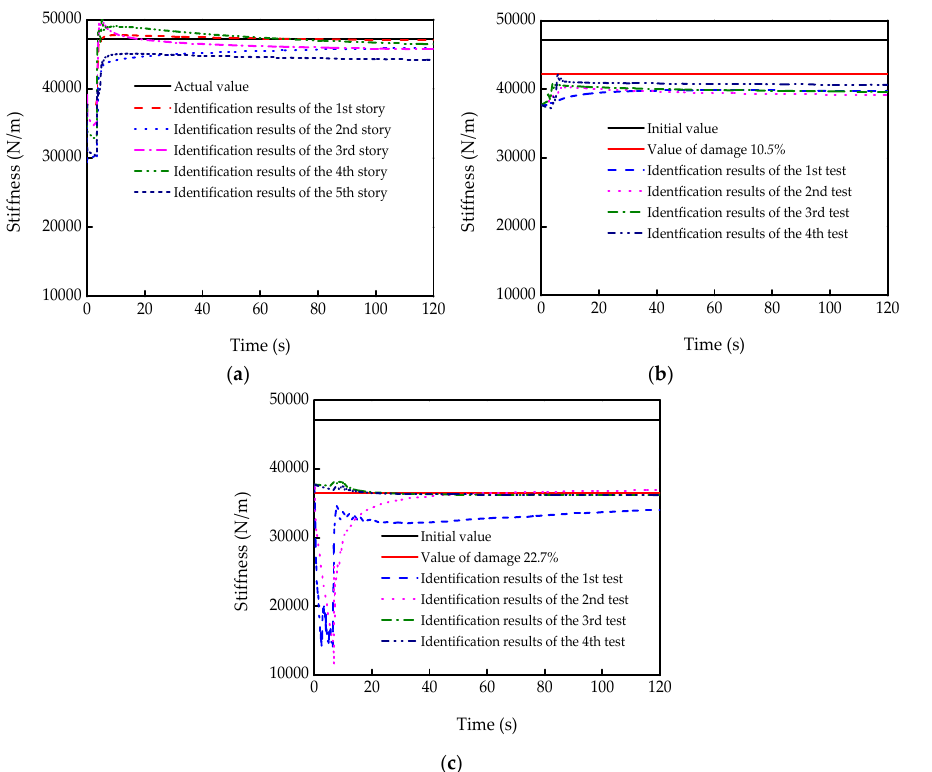
Figure 17. Stiffness identification of each damage case: ( a ) case 1; ( b ) the 5 th story in case 2; ( c ) the 4 th story in case 3.